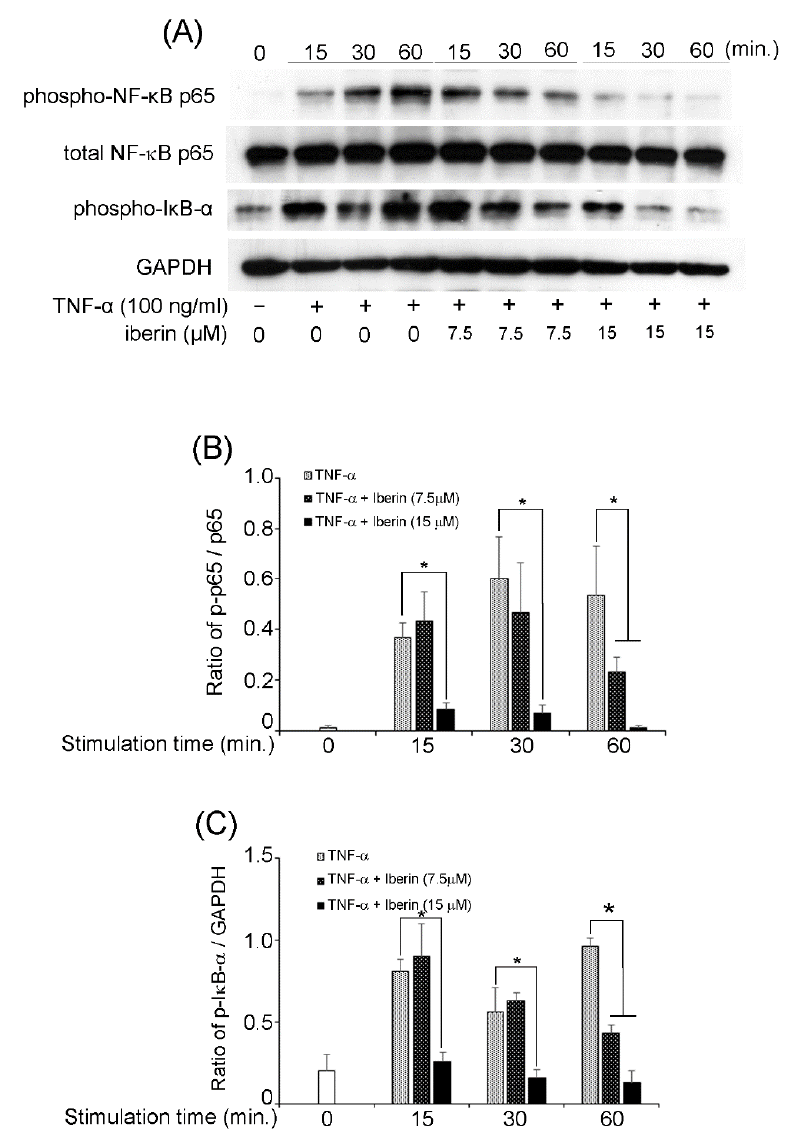
Figure 5. The effects of iberin treatment on the activation a NF- κ B pathway in TNF- α stimulated TR146 cells. TR146 cells were pretreated with iberin (7.5 or 15 µ M) for 1 h before being stimulated with TNF- α for 15, 30, or 60 min, and the phosphorylation of NF- κ B p65 and I κ B- α was measured using Western immunoblotting. ( A ) Representative Western blot image of the expression of phospho-NF- κ B p65, total NF- κ B p65, phospho-I κ B- α , and GAPDH. ( B , C ) Quantification of protein expression by densitometry analysis of Western blots. Data are expressed as the mean ± SD of three independent experiments. (* = p < 0.05).